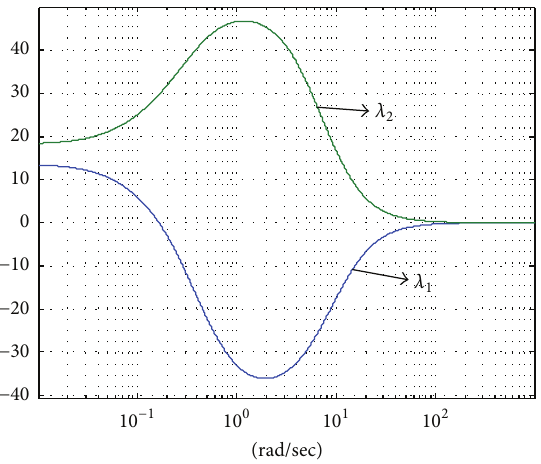
Figure 8: Eigenvalues of [𝐺 𝑜3 (𝑗𝜔) + 𝐺 ∗ 𝑜3 (𝑗𝜔)] (Case 3